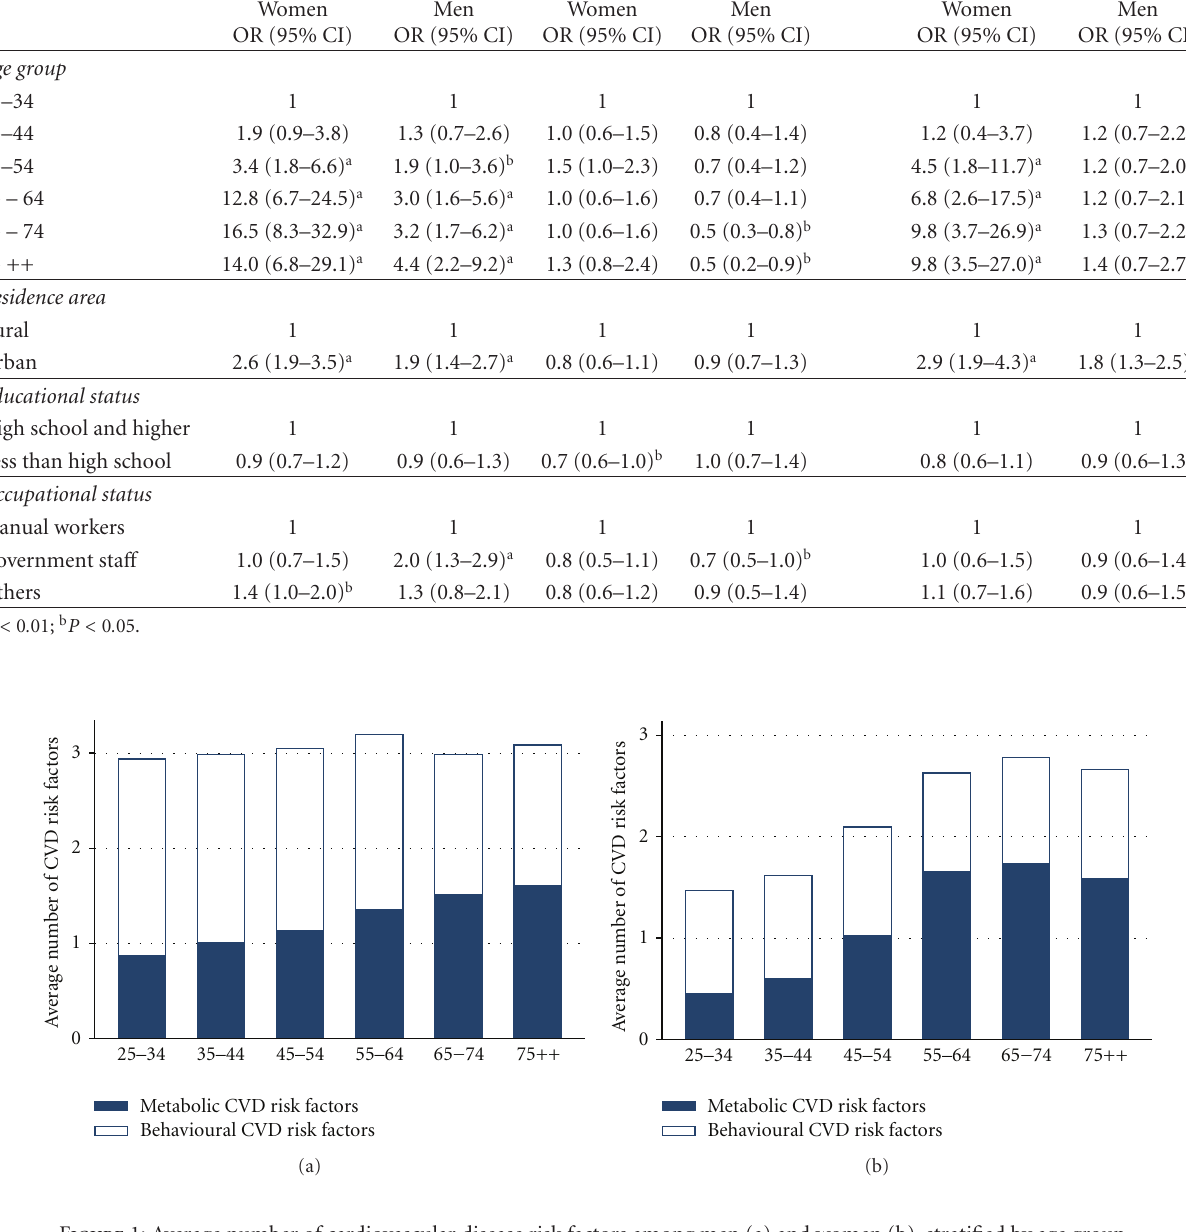
Figure 1: Average number of cardiovascular disease risk factors among men (a) and women (b), stratified by age